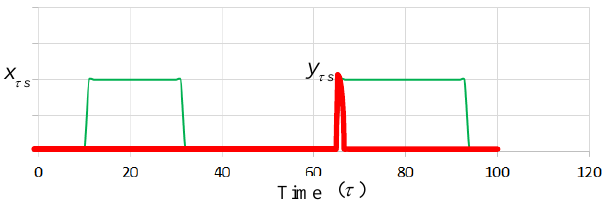
Figure 2. Presentation of server switching on or